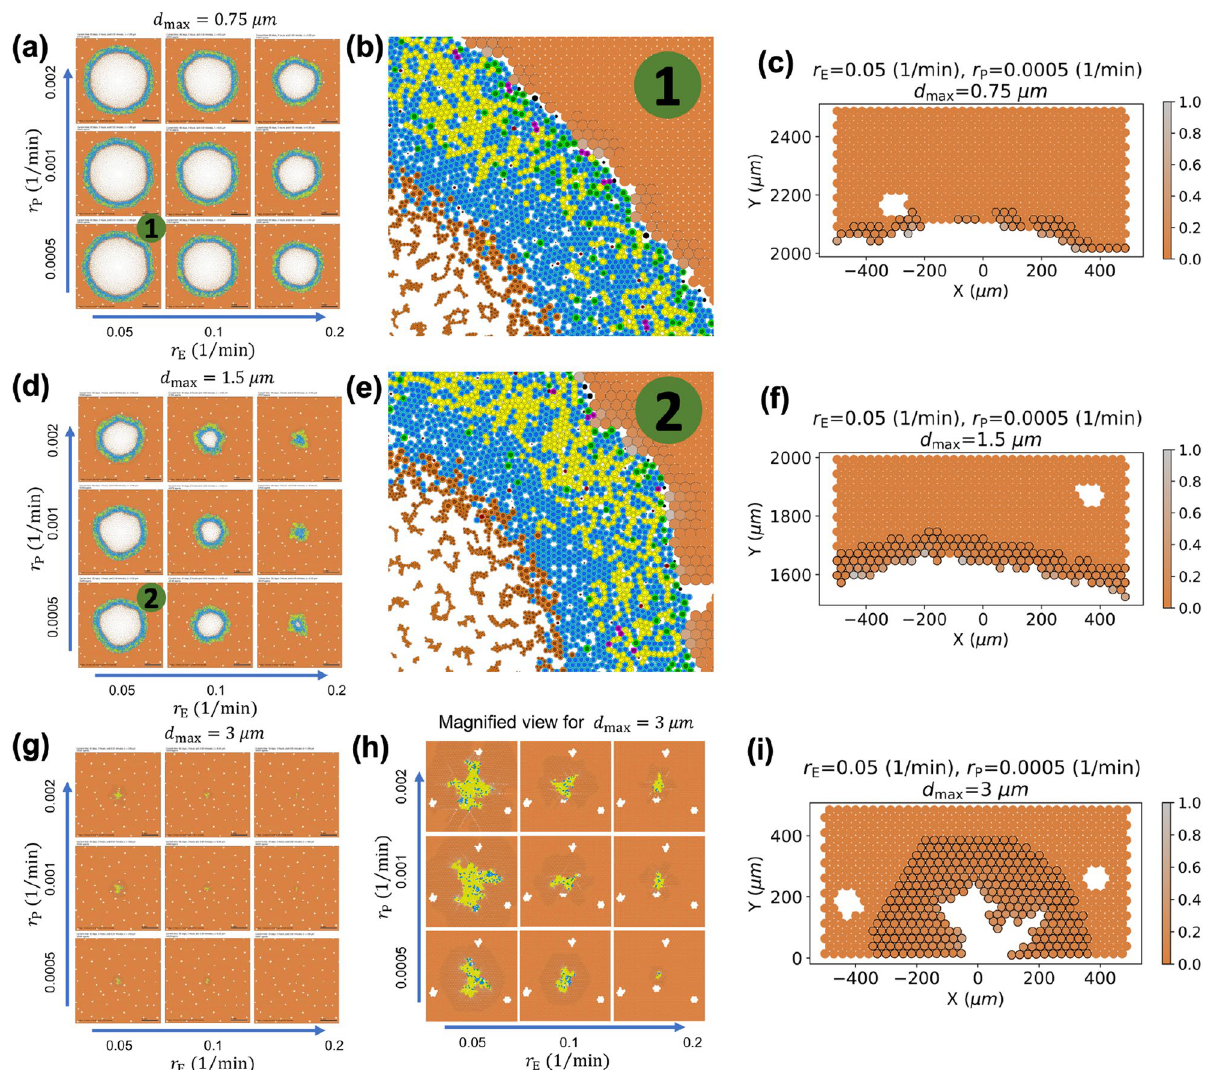
Figure 5. ( a , d , g ) Final tumor shapes at t = 90 days in 0.5 cm × 0.5 cm liver tissue with different biomechanical parameters ( r E : elastic response rate; r P : plastic relaxation rate; d max : maximum tolerated deformation). ( h ) 5 × magnification of the tumors in ( g ). ( b , e ) 6 × magnification of the tumor boundary section in 1 (cid:31) and 2 (cid:31) of corresponding parameters in ( a , d ). ( c , f , i ) Cropped section of viable parenchyma in tumor boundaries of three different maximum tolerated displacement. Parenchyma agents that have at least 1% of their maximum tolerated displacement are outlined with black edge color, and agents are colored by their relative strain (from bright orange to light gray). Tumor cells are shaded blue (Ki67−), green (Ki67+ prior to division), magenta (Ki67+ after division), red (apoptotic), or brown (necrotic). Yellow tumor cells have pressure p exceeding their tolerance and will arrest in the Ki67− state. Liver parenchyma is shaded from bright orange (no deformation) to light gray (maximum tolerated deformation), and black parenchyma is apoptotic. Black outlined parenchyma agents have been displaced at least 1% of their maximum tolerated displacement. Original high-resolution SVG files are included in github repository: https ://githu b.com/MathC ancer /liver -mecha nobio show a hematoxylin and eosin (H&E) stained whole slide image of human liver tissue with a colorectal cancer metastasis. Regions of compressively strained liver parenchyma (C) are macroscopically observable near the tumor boundary (dashed line), visible as regions of more concentrated eosin staining. See Fig. 8A. In a magnified view of the sample (Fig. 8B), we see that the parencyhma nearest to the tumor is highly aniso- tropic: it has been compressed in the direction parallel to the tumor boundary (in the direction of tumor growth), and stretched in the direction parallel to the boundary. This is consistent with deformation from a growing tumor: compression in the direction of growth, and stretch in the direction parallel to the interface. Moreover, just as in the simulations, the greatest parenchyma deformation happens nearest to the tumor (annotated as C), and the deformation extends out into the tissue with decreasing effect (C*).